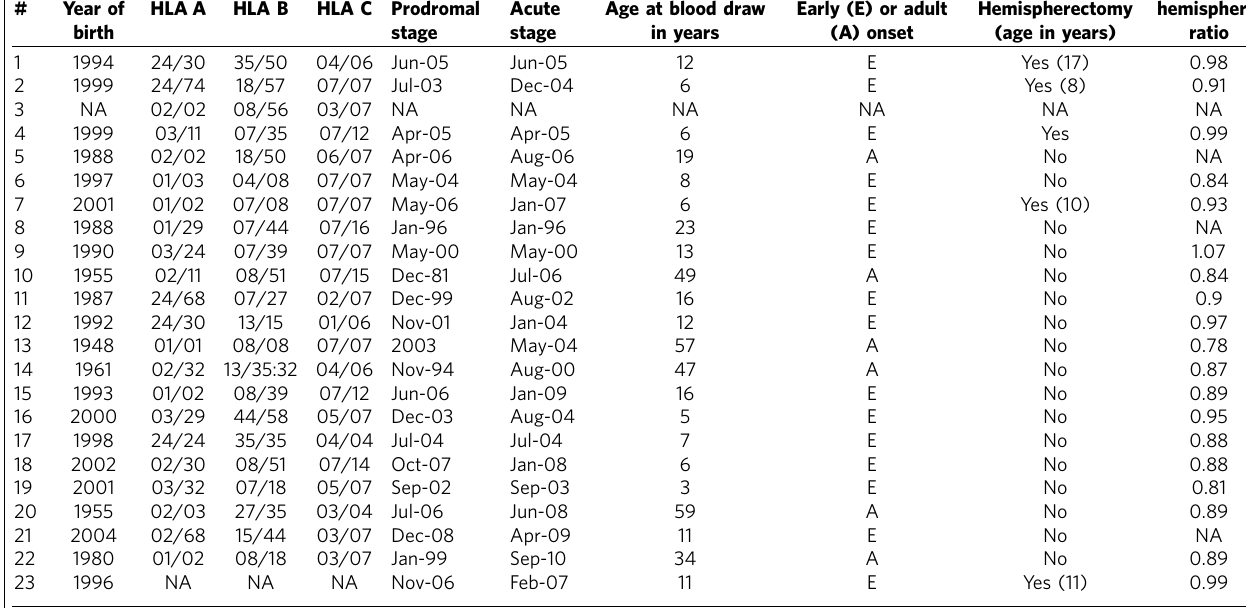
Table 3 | Details of the RE patient